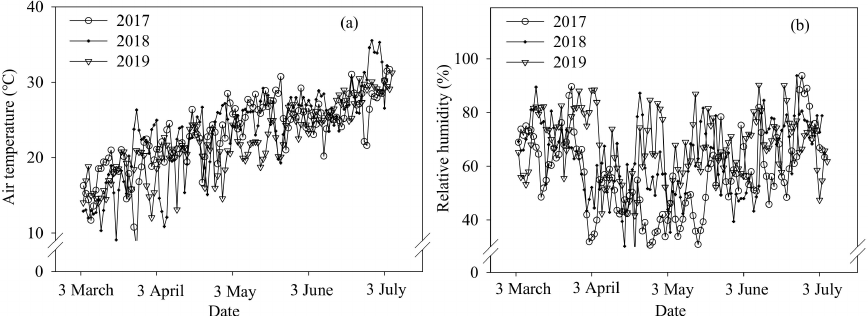
Figure 1. Seasonal variation of air temperature ( a ) and relative humidity ( b ) during the study period in 3 consecutive